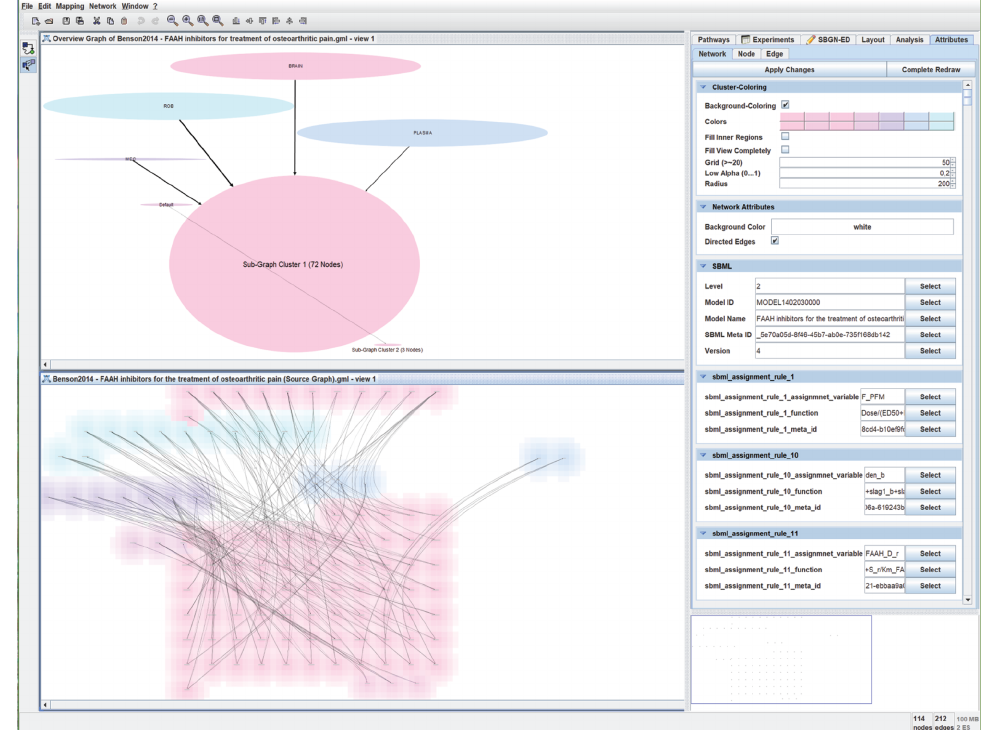
Figure 3: NetPartVis uses an overview graph G (shown at the top, created from the source graph, shown at the bot- O tom), to influence the placement of clusters in the source graph G . Here, the source graph has been downloaded from the BioModels database (https://www.ebi.ac.uk/biomodels/BIOMD0000000512) using Vanted 2.6.5. In addition to the pre-existing clusters given by BioModels (BRAIN, ROB, PLASMA, MEC and Default), the rest has been determined via the connected sub-graphs feature. Cluster background colouring (set from the Network Attributes Tab on the right) and edge bundling have been applied to the source